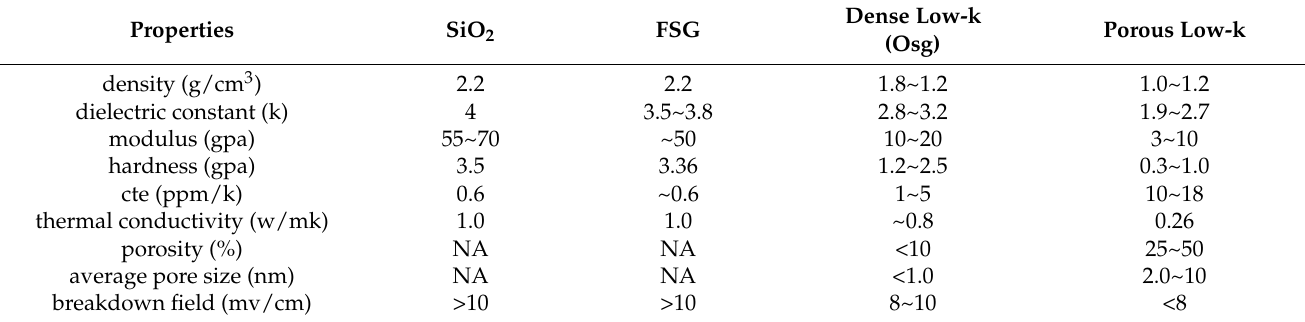
Table 1. Essential properties of representative dielectric materials